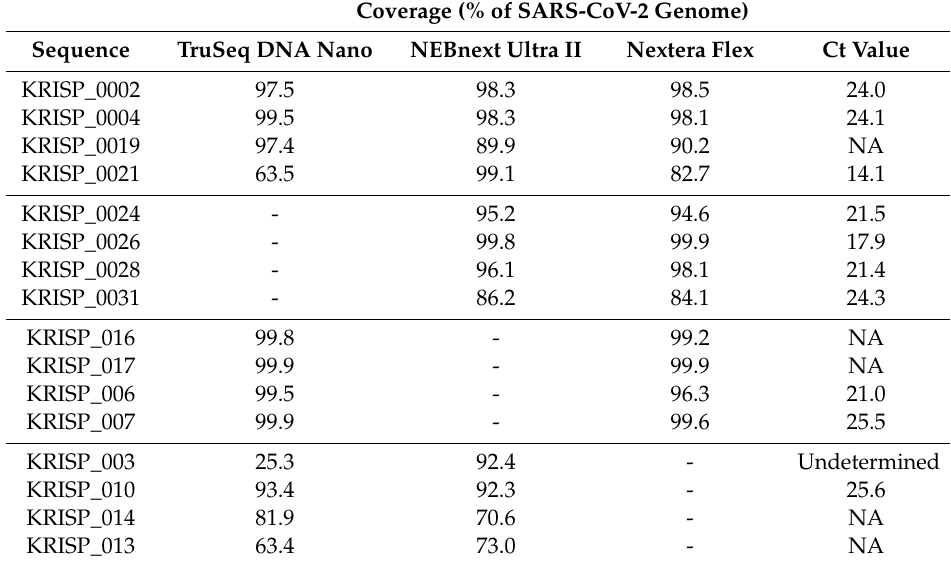
Table 1. Comparison of coverage and Ct values between the di ff erent library preparation methods for repeat samples